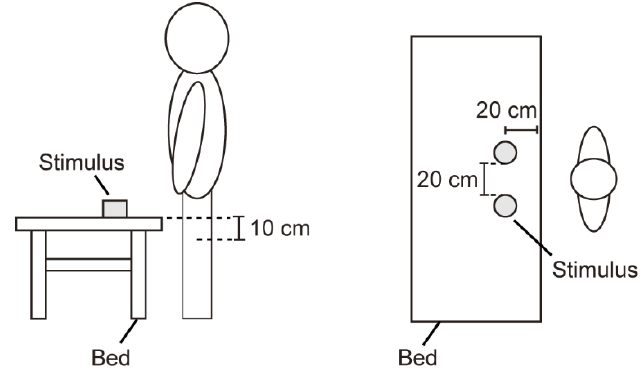
Figure 2. Location of the presented stimuli.